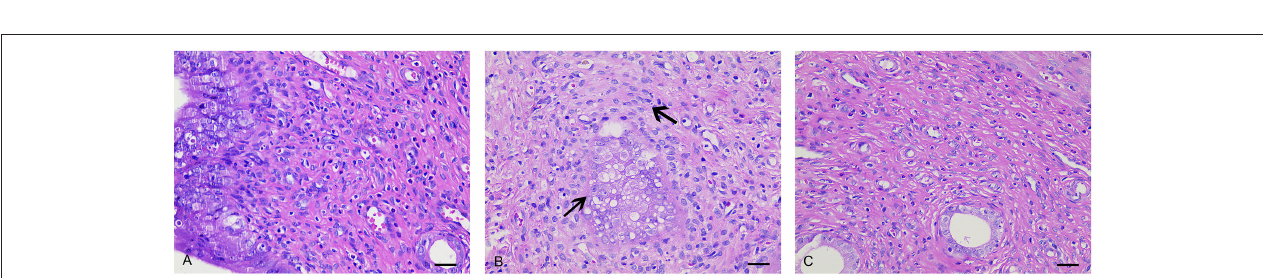
FIGURE 1 | Representative images of morphology of a rat uterus after CRSR treatment. The uterus of a NC rat (A) was bilaterally symmetrical, without swelling nodules and cysts. Significant swelling, nodules, and cysts (arrows) appeared in the UL group (B) . The CRSR uterus morphology (C) tended to match that of the NC group (A) . NC, normal control group; UL, uterine leiomyoma model group; CRSR, Curcumae Rhizoma and Sparganii Rhizoma treatment group.